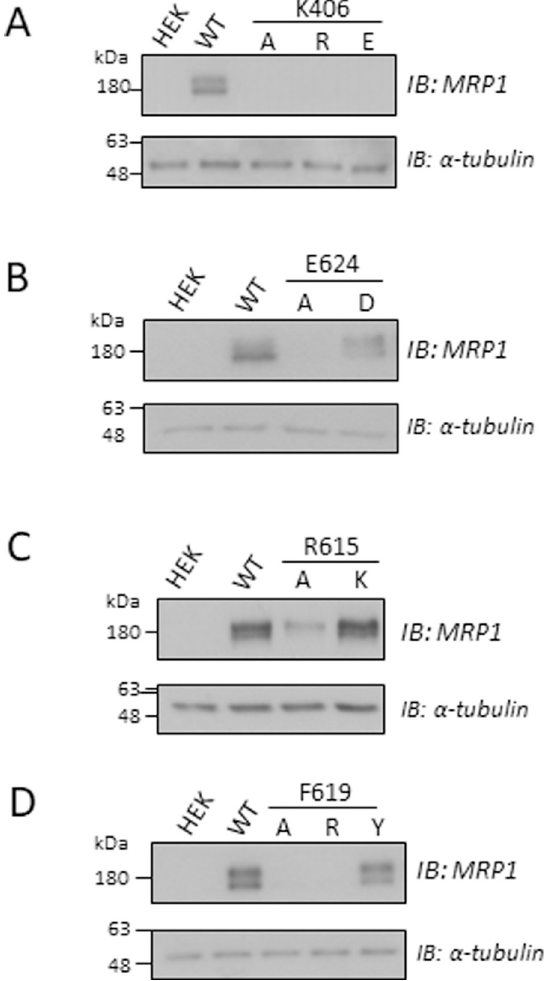
Fig 6. Levels of mutant MRP1 proteins in transfected HEK cells. Shown are immunoblots of cell extracts (10 μ g protein per lane) prepared from HEK cells transfected with pcDNA3.1(-) expression vectors encoding wild-type MRP1 (WT) and (A) single K406A/R/E mutants; (B) single E624A/D mutants; (C) single R615A/K mutants; and (D) single F619A/R/Y mutants. Untransfected cells (HEK) served as a negative control. Relative MRP1 levels were quantified by densitometry and adjusted as needed to take into account differences in gel loading by probing blots with antibodies against α -tubulin (loading control). Blots shown are from single experiments; comparable results were obtained in at least one additional independent transfection and immunoblot. For conservative mutants R615K, E624D, and F619Y, levels were comparable to wild-type hMRP1 (1.3, 0.8, and 1.0-fold, respectively; means of 2 independent observations). The images in each panel are from a single blot with the region between MRP1 and the loading control cropped out.